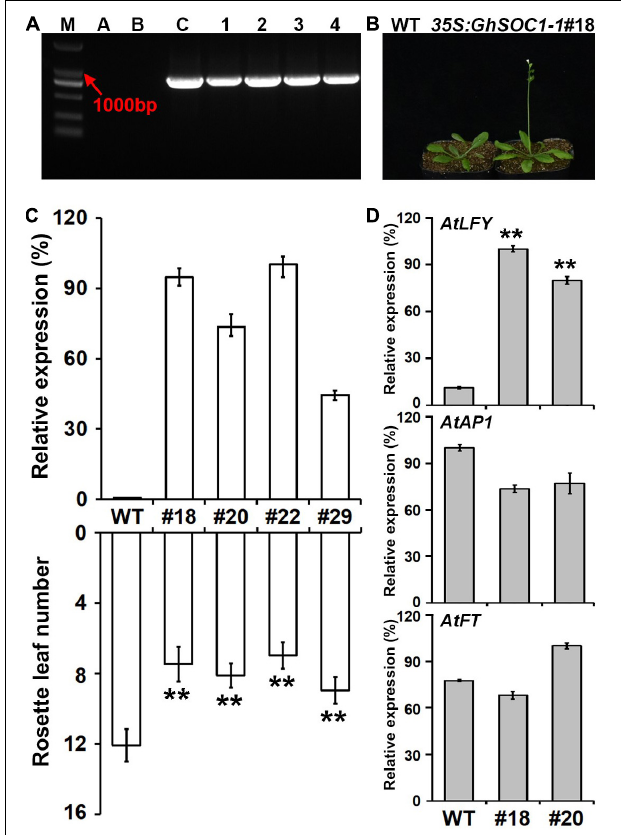
FIGURE 5 | Overexpression of GhSOC1-1 promotes flowering of Arabidopsis . (A) Genotype verification of positive plants in T1 generation. M, DNA molecular weight marker DL 2000; A-C, water control, WT control and positive control; 1-4, PCR detection of positive plants. (B) Phenotype of T3 generation line. (C) Relative expression of GhSOC1-1 and statistics of flowering time in transgenic lines and wild-type Arabidopsis . Asterisks indicate statistically significant differences according to Student’s t -test (** P < 0.01). (D) Expression of AtLFY, AtAP1, and AtFT in transgenic and wild-type Arabidopsis. The expression is normalized to AtTUB2 and the maximum expression is set as 100%. Error bars represent the standard deviations of three biological